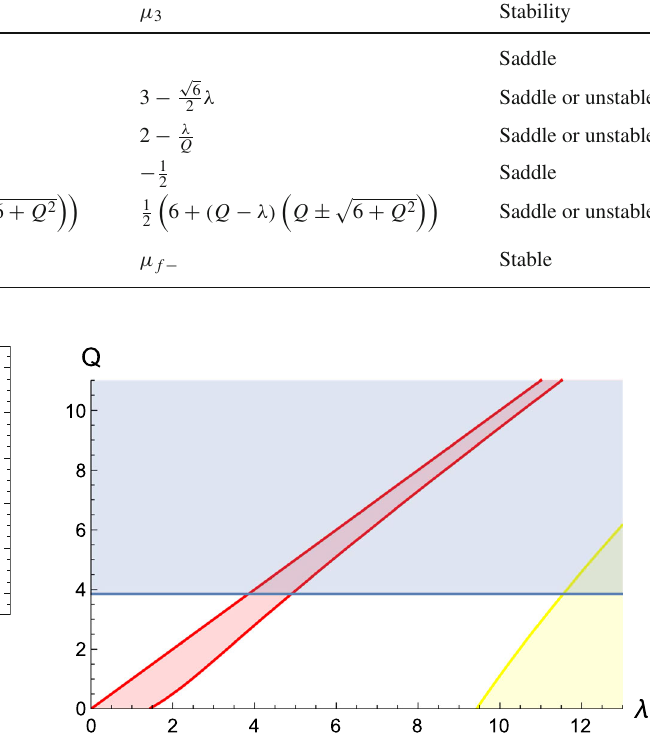
Fig. 2 Allowedregionsof Q ,forthefixedpoints(a)( yellow ),(c)( blue ) and (f) ( red